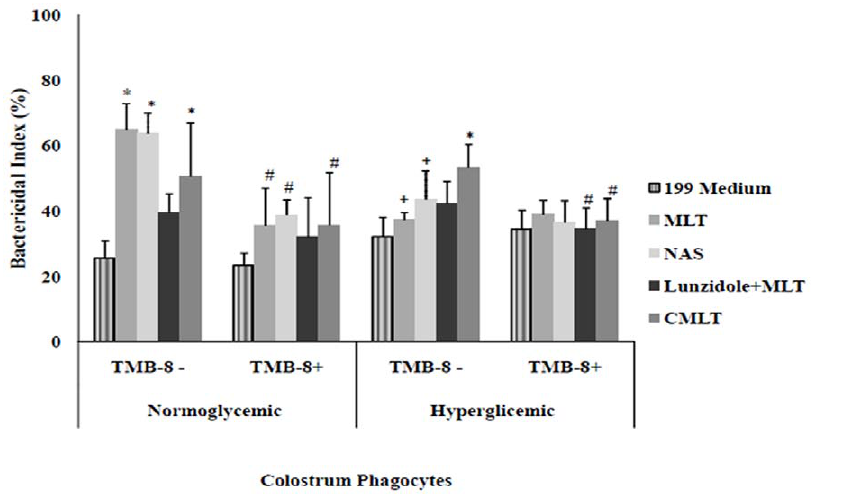
Figure 3. Bactericidal index (mean ± SD, N=7 in each treatment). Bactericidal activity by colostral phagocytes was determined with the acridine orange method. Phagocytes were pre-treated or not with 8-(Diethylamino) octyl-3,4,5-trimethoxybenzoate hydrochloride (TMB-8) and incubated with enterophatogenic Escherichia coli (EPEC) in the presence of melatonin (MLT), N-acetyl-serotonin (NAS), luzindole or chloromelatonin (CMLT). * indicates difference from the 199 medium (ANOVA, P , 0.05); + indicates intergroup differences within each treatment (ANOVA, P , 0.05); # indicates differences between TMB-8 use within each treatment and group.